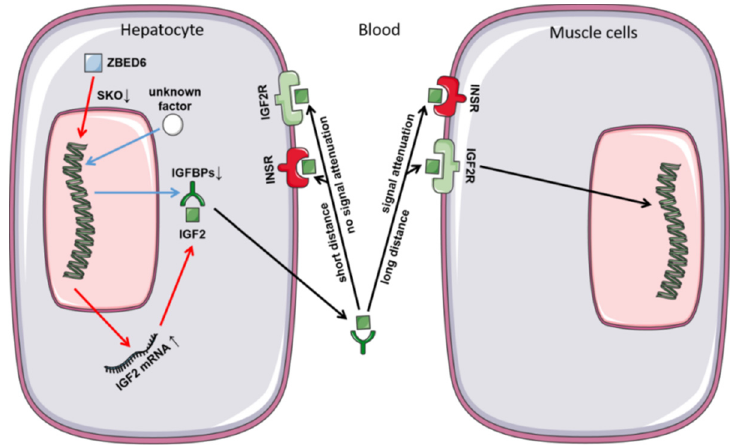
Figure 6. Secretion and function of IGF2 in ZBED6 -SKO pig hepatocyte and muscle cells.